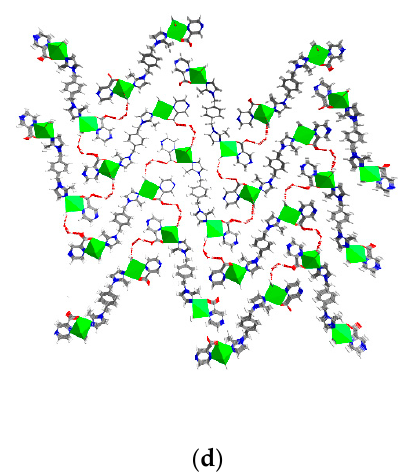
Figure 3. The structure of compound 3 : ( a ) coordination environment of the Cu(II) ion (symmetry transformations used to generate equivalent atoms: 1 1 + X, +Y, +Z; 2 − X, − Y, − Z; 3 − 1 + X, +Y, +Z);